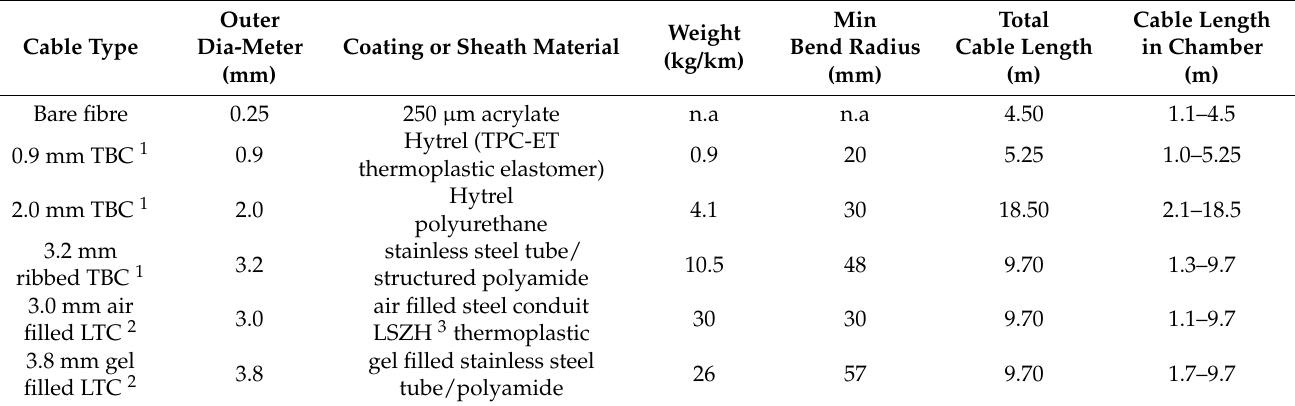
Table 1. Cable types, parameters and configurations.